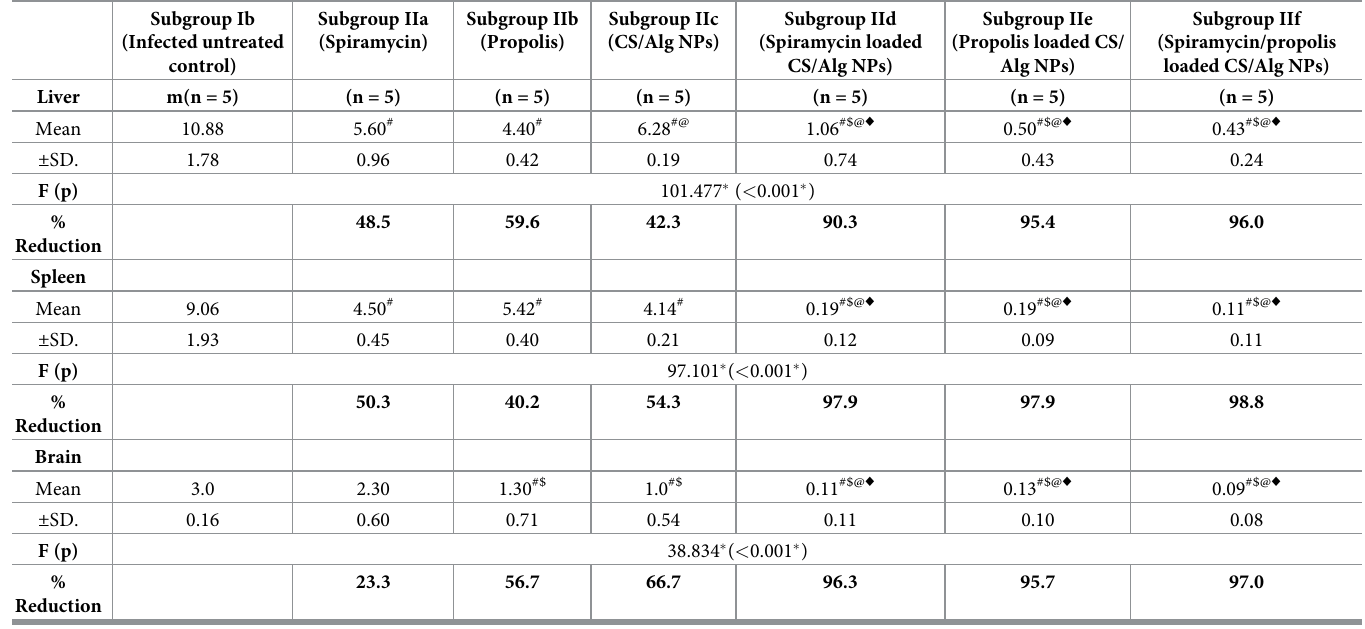
Table 3. Parasite count and percent reduction in liver, spleen and brain among the different studied subgroups. Subgroup Ib (Infected untreated